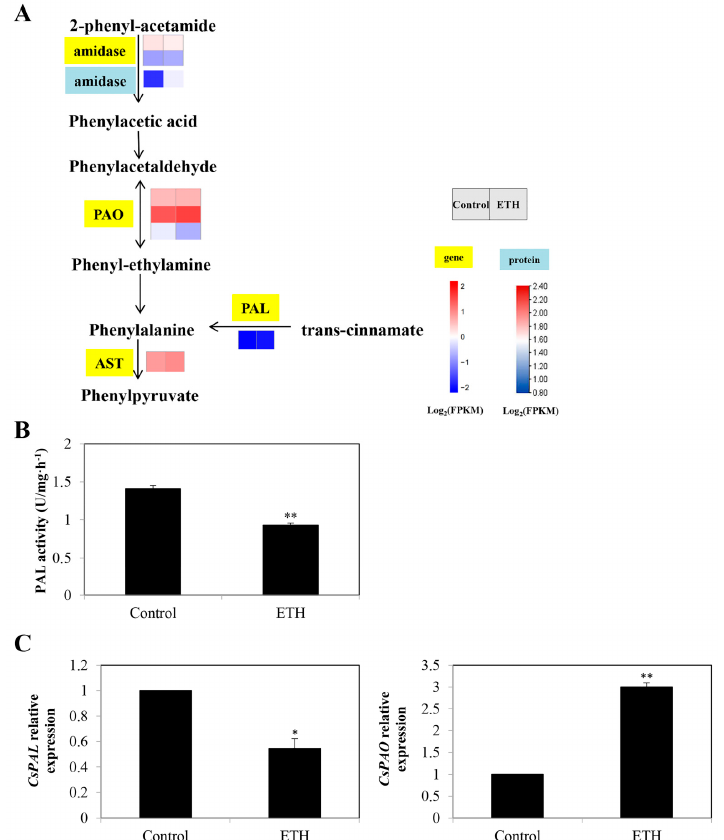
Figure 5. Identification and validation of key DEGs in phenylalanine metabolism during adventitious root development in cucumber. ( A ) Expression patterns of genes and proteins for phenylalanine metabolism in secondary metabolism during adventitious root development in cucumber. Annota- tions of genes and proteins are available in Supplementary Table S8. Black characters with yellow background are genes, whereas black characters with blue background are proteins. The two squares under the names of genes or proteins indicate the change in abundance of the control and ETH. A red square means up-regulation, whereas a blue square means down-regulation. ( B ) The activity of PAL and PAO enzyme during adventitious root development in cucumber. ( C ) Quantitative real-time PCR analysis of the expression profiles of 2 genes related to phenylalanine metabolism during adventitious root development in cucumber. Asterisk (*) and double asterisk (**) indicate the significance at p < 0.05 and p < 0.01, respectively. The bar represents the value of standard error. Values represent the mean ± SE of three replicates. Each experiment was repeated three times